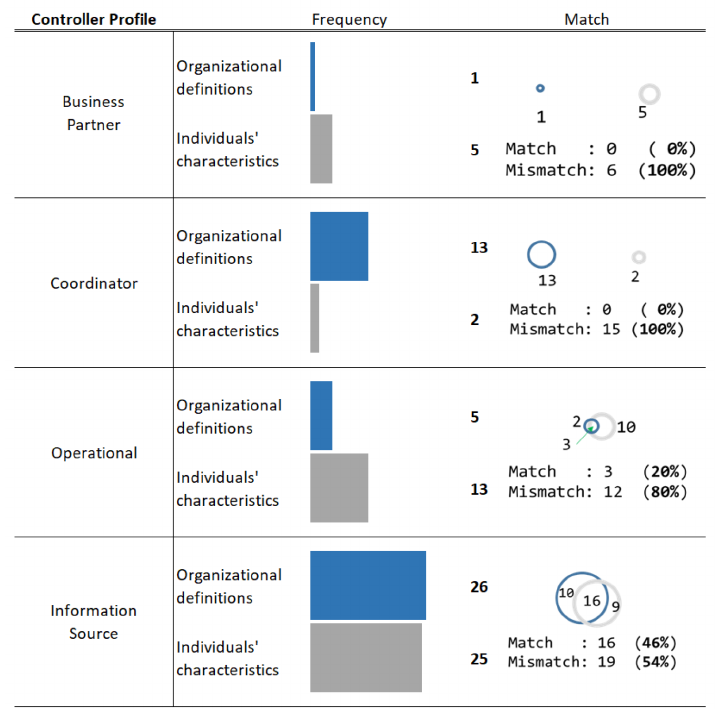
Table 2. Match according to dominant profiles in each dataset